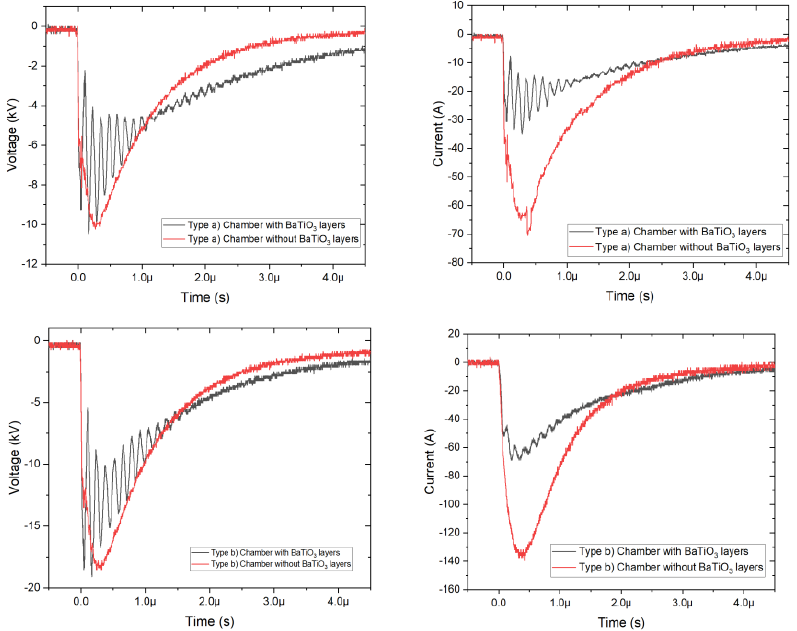
Figure 5. Actual voltage and current waveforms obtained during PEF treatment using different PEF chambers.